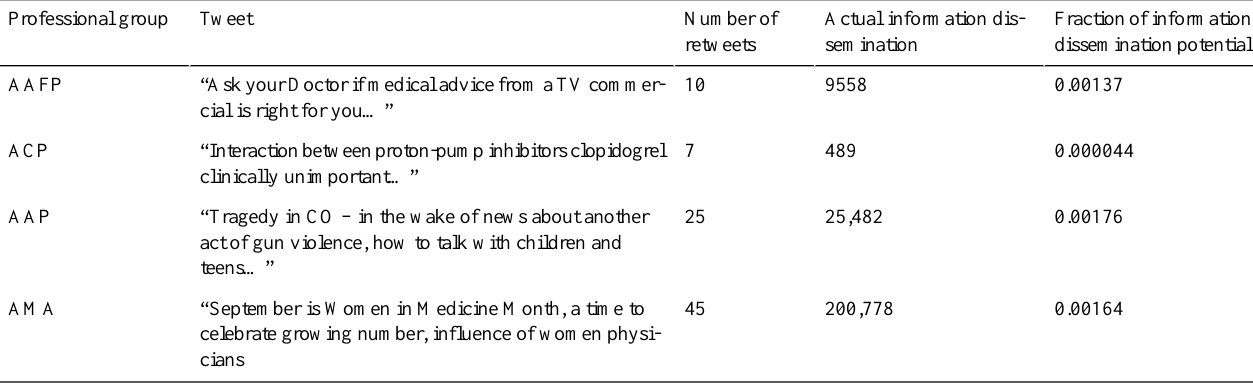
Table 3. Top tweets for each professional group.